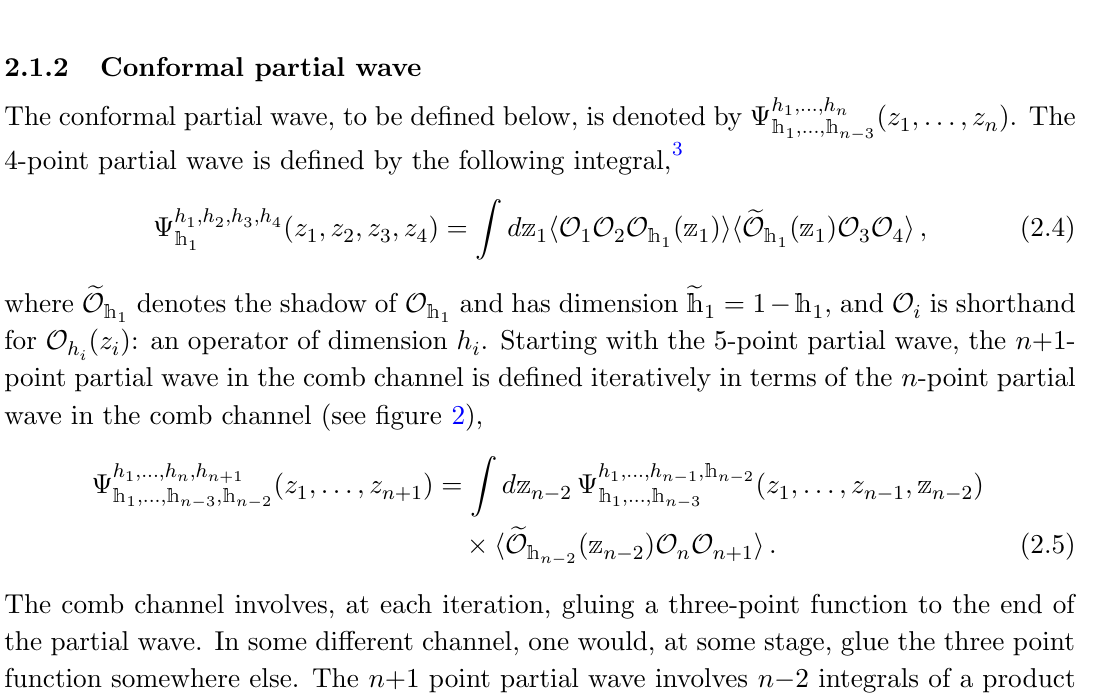
Figure 2. The n -point conformal partial wave in the comb channel. Each vertex denotes a conformal three-point function. Each line denotes a position. Internal lines denote positions that are integrated over. The h i denote the dimensions of the external operators, and the h i are the dimensions of the exchanged